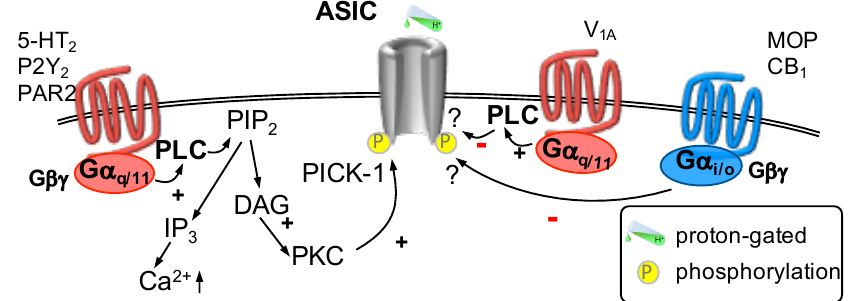
Figure 2. Acid sensing ion channels (ASIC) are gated by increasing concentrations of H + . Two G-protein pathways modulate the function of ASICs. Activation of G α q /11 -coupled receptors ( left ) leads to activation of phospholipase C (PLC) which hydrolyzes phosphatitylinositol 1,4, bisphosphate (PIP 2 ) into inositiol 1,4,5 trisphosphate (IP 3 ) and diacylglycerol (DAG). DAG activates protein kinase C (PKC) which phosphorylates ASICs increasing their function. The interaction of PKC with ASICs requires the presence of PICK-1 (protein interacting with C-kinase 1). By contrast, activation of G α q /11 -coupled V 1 A receptors ( center ) were shown to decrease ASIC-mediated currents via an unknown mechanism. Stimulation of G α i / o -coupled receptors ( right ) was shown to decrease currents through ASICs involving an undetermined